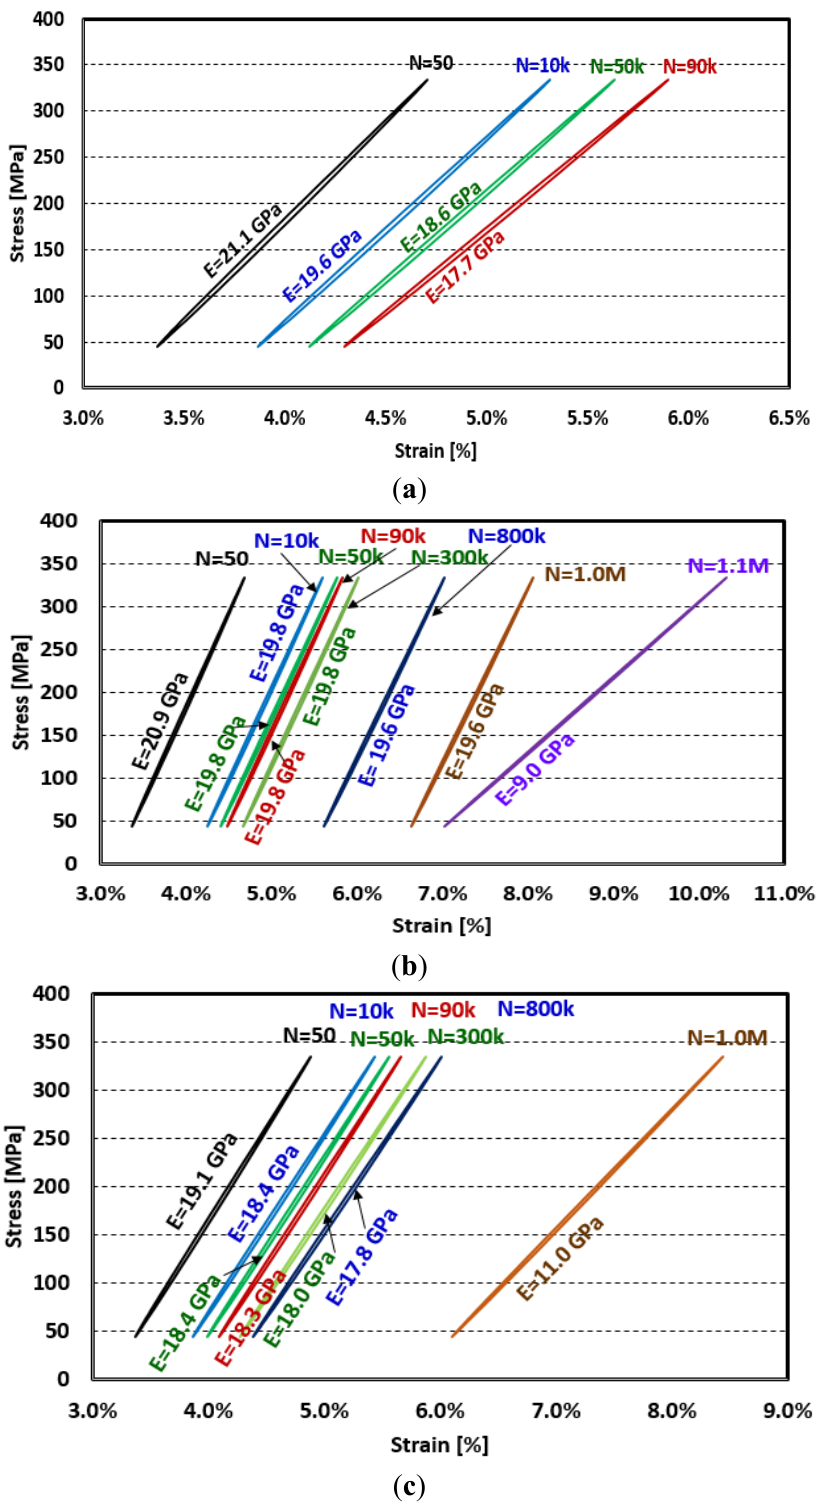
Figure 4. Change in stress-strain hysteresis for GFRP composites incorporating ( a ) 0% MWCNTs (neat); ( b ) 0.5% MWCNTs; ( c ) 1.0% MWCNTs. (N is number of